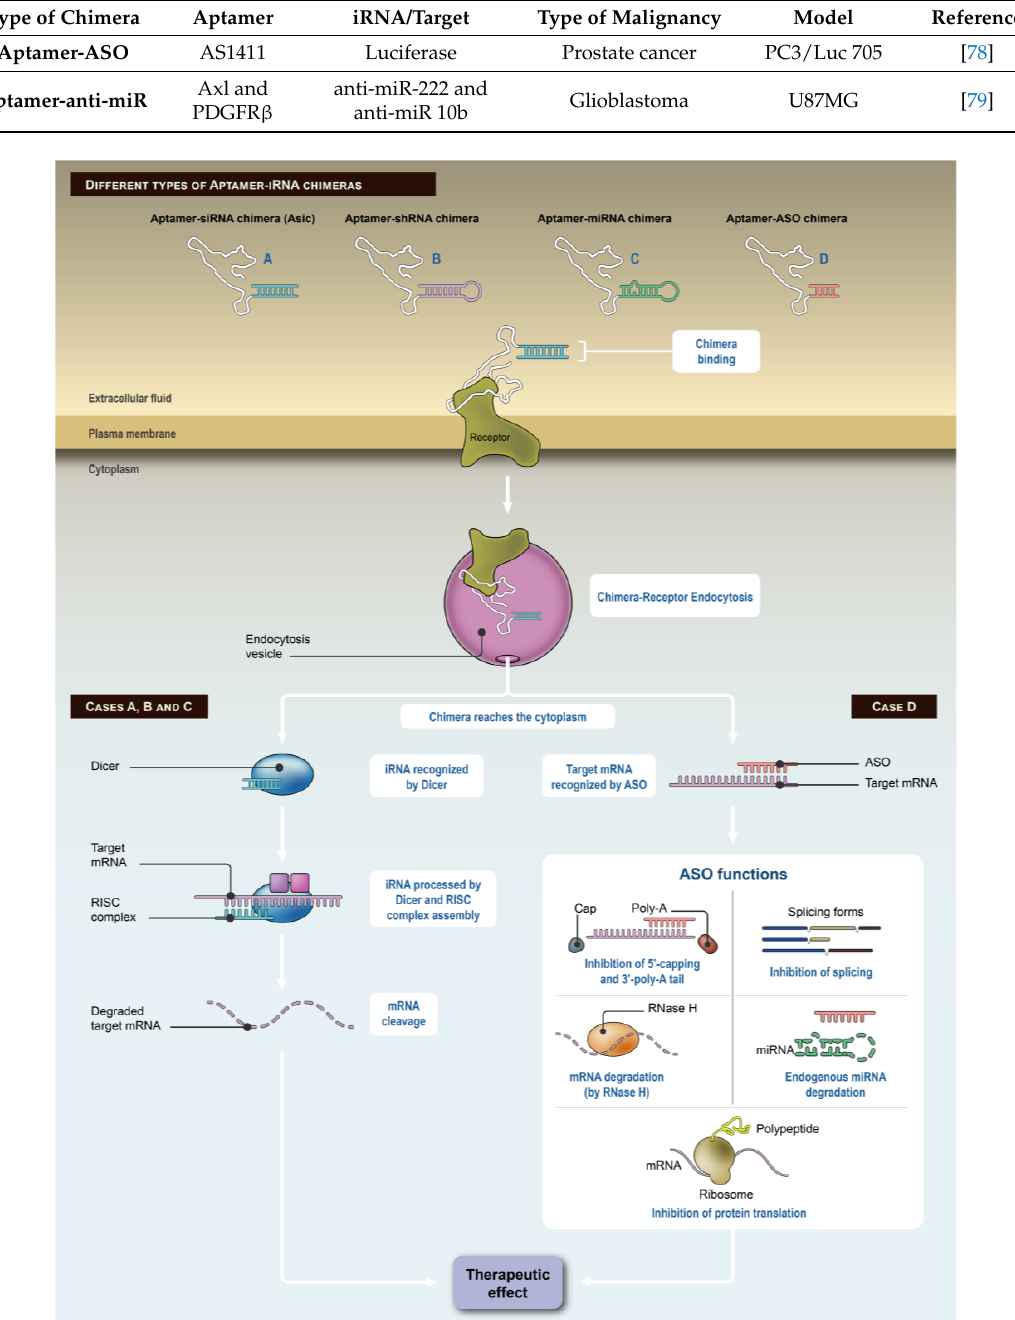
Figure 1. Aptamer-iRNA processing depending on the type of aptamer-iRNA chimera: ( A ) Aptamer-siRNA (AsiC); ( B ) Aptamer-shRNA; ( C ) Aptamer-microRNA, and ( D ) Aptamer-antisense oligonucleotide (ASO). Aptamer-iRNA chimera binds the aptamer receptor and upon engagement the chimera-receptor is embedded into an endocytosis vesicle. The chimera reaches the cytoplasm and in cases A, B, and C, the duplex iRNA is recognized by Dicer and loaded into Dicer and RNA-induced silencing complex (RISC) assembled to the target mRNA to be further degraded, and therefore exerts its therapeutic function. In case D, ASOs may exert their function by five different mechanisms: inducing RNAse H-mediated mRNA degradation, preventing 5’-capping and 3’-polyadenilation of the pre-mRNA, direct inhibition of protein translation, inhibition of splicing, or induction of endogenous micro-RNA